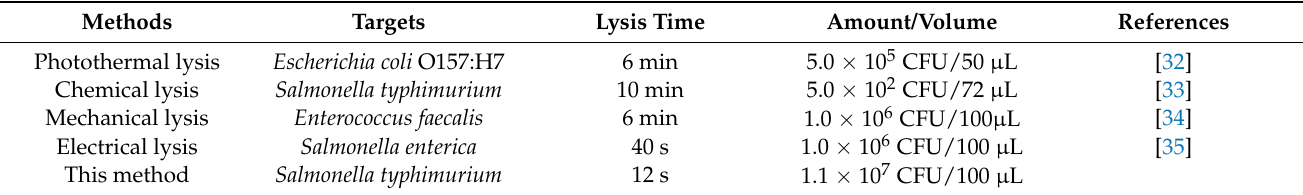
Figure 2. The eddy heating for bacterial cells lysis. ( A ) The photo of the eddy heater: ① the iron rod, ② the spiral channel, ③ and the alternating electromagnetic field generator. ( B ) The simulation on the temperature of deionized water in the spiral channel (unit: K). ( C ) The Ct values of Salmonella cells at 1.1 × 10 6 CFU/mL for different flow rates (N = 3). ( D ) The Ct values of Salmonella cells at 1.1 × 10 7 CFU/mL for different lysis time (N = 3). ( E ) The Ct values for different concentrations of Salmonella cells at the flow rate of 0.5 mL/min (N = 3). * indicated significance difference, p < 0.05. Table 1. Comparison of this lysis method with recently foodborne pathogens lysis method.